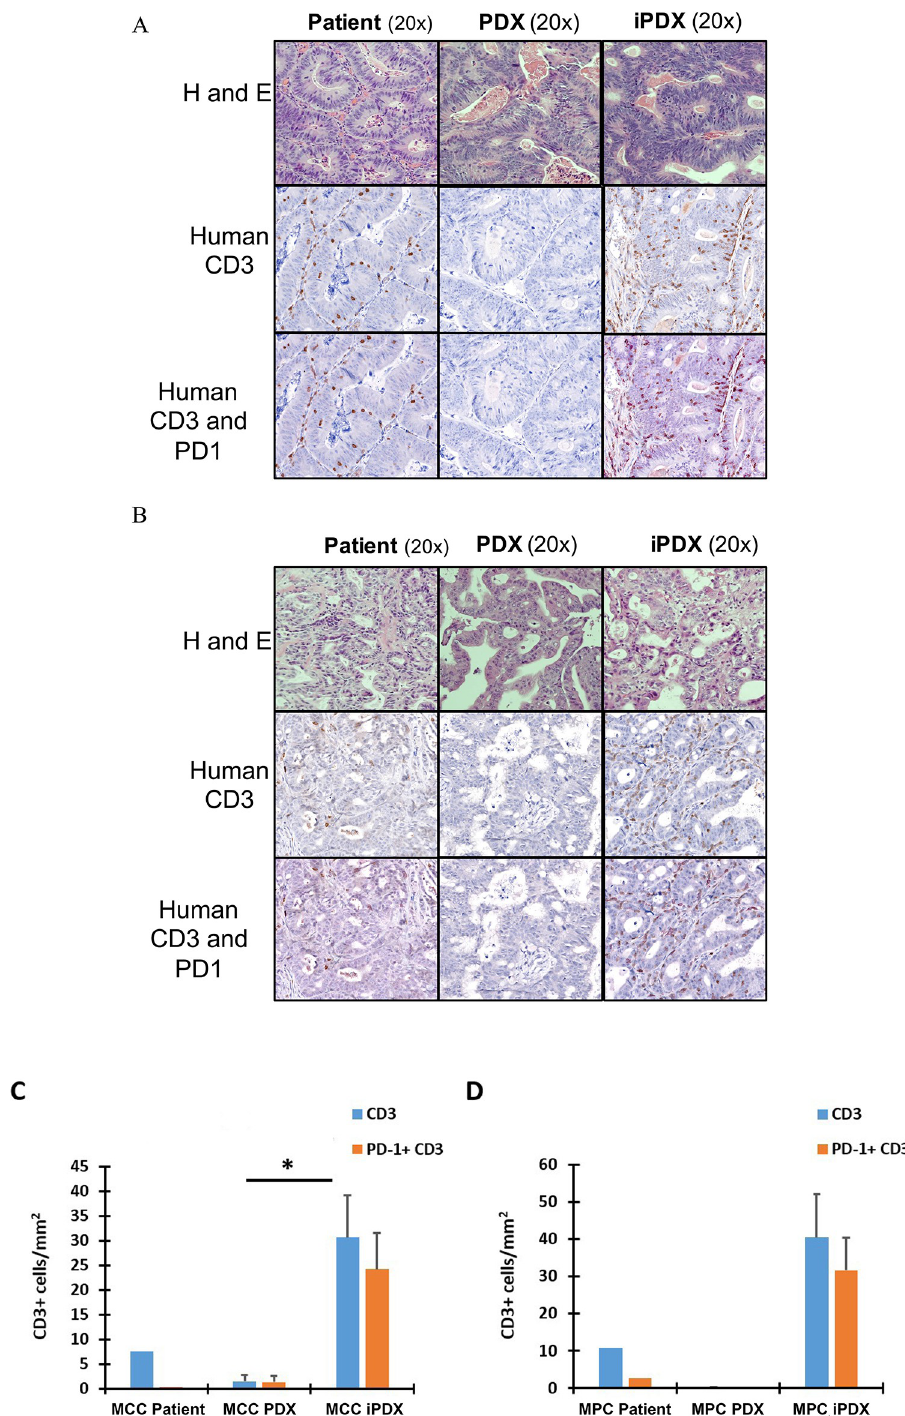
Fig 2. Comparison of histopathologic features of the corresponding human tumor to the xenograft models. Histopathological evaluation of (A) MCC and (B) MPC models by Hematoxylin and Eosin staining (top row), human CD3 (middle row), and PD-1 and CD3 dual staining (bottom row) comparing the corresponding human tumor, PDX and iPDX tumors at 20X magnification. (C) and (D) Quantification of CD3 and PD-1 expression in the human cancer, MCC and MPC models. Data from samples collected at the end of the experiment at 7–8 weeks. Values represent mean of three animals per group ± SD. � p < 0.05.